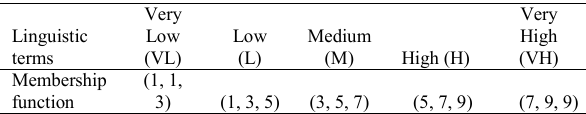
Table 2. Linguistic terms used by the weighting